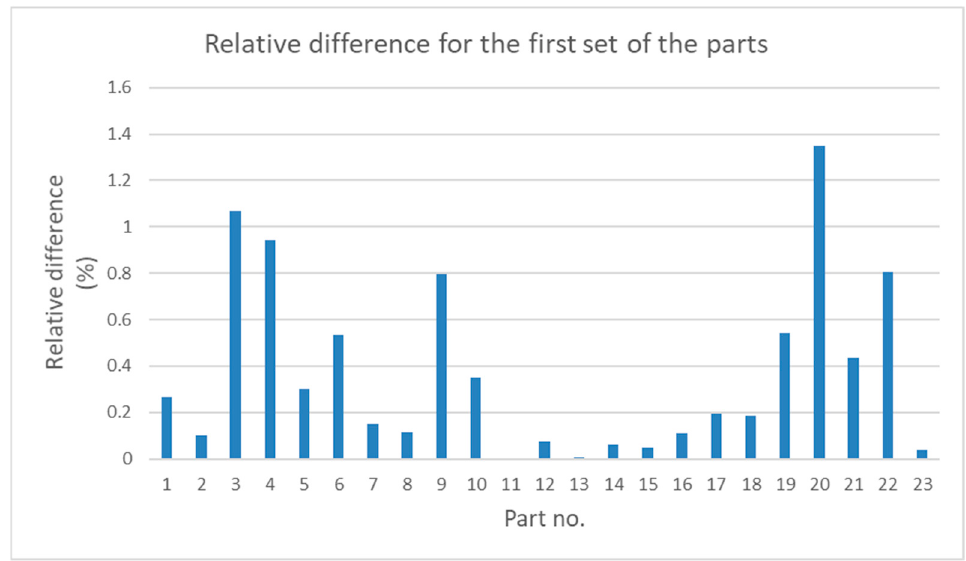
Sensors 2021 , 21 , x FOR PEER REVIEW Figure 6. Relative differences between the values of deviations obtained with the use of the new and traditional methods for the first set of parts.